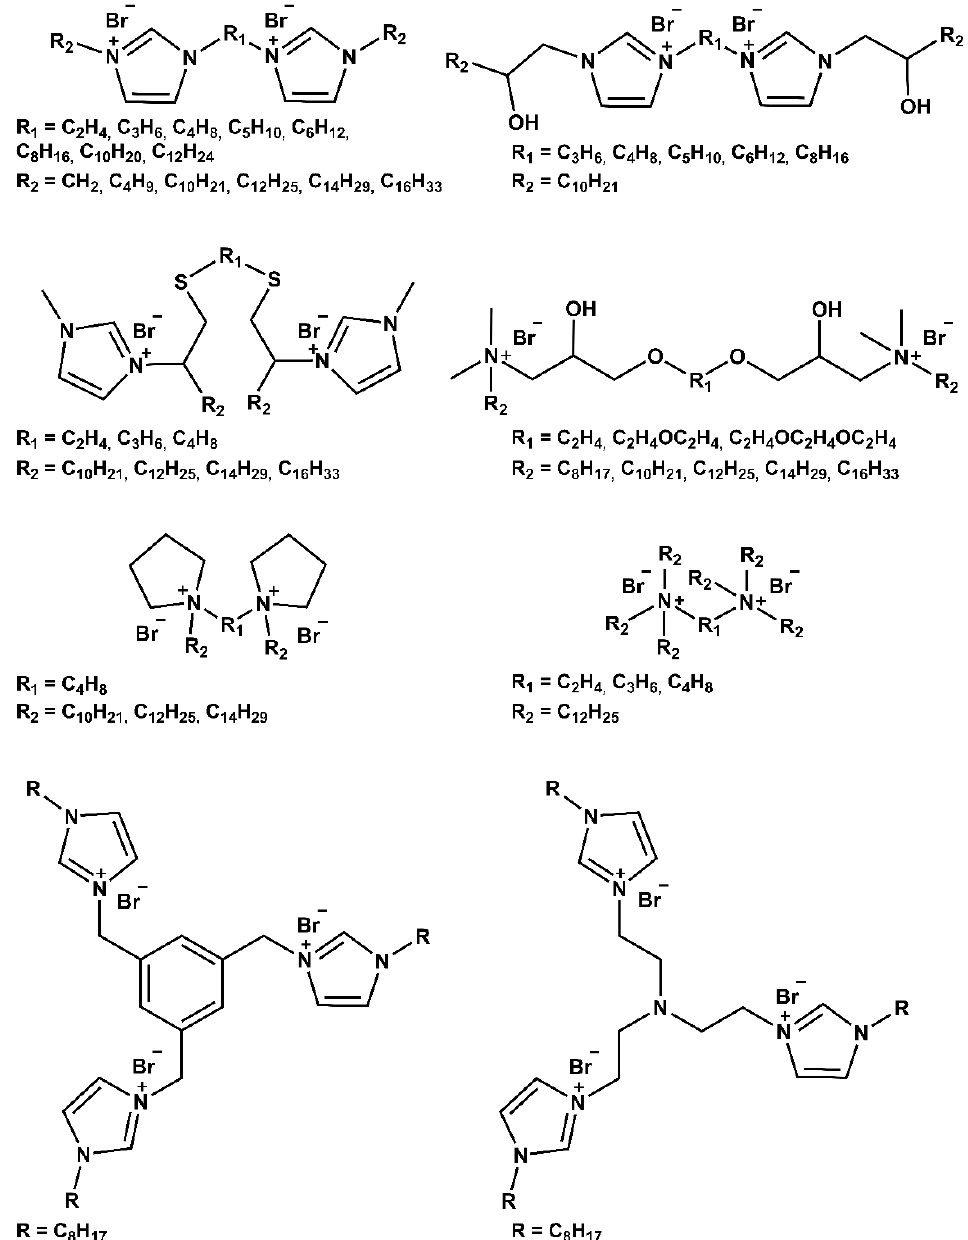
Table 2. Literature data on aqueous solutions of gemini ionic liquid-based surfactants at 25 °C. Adsorption and micellar parameters calculated from surface tension data. All surfactants have two bromides as counterions, except for entries 54 and 55, which have three bromides as